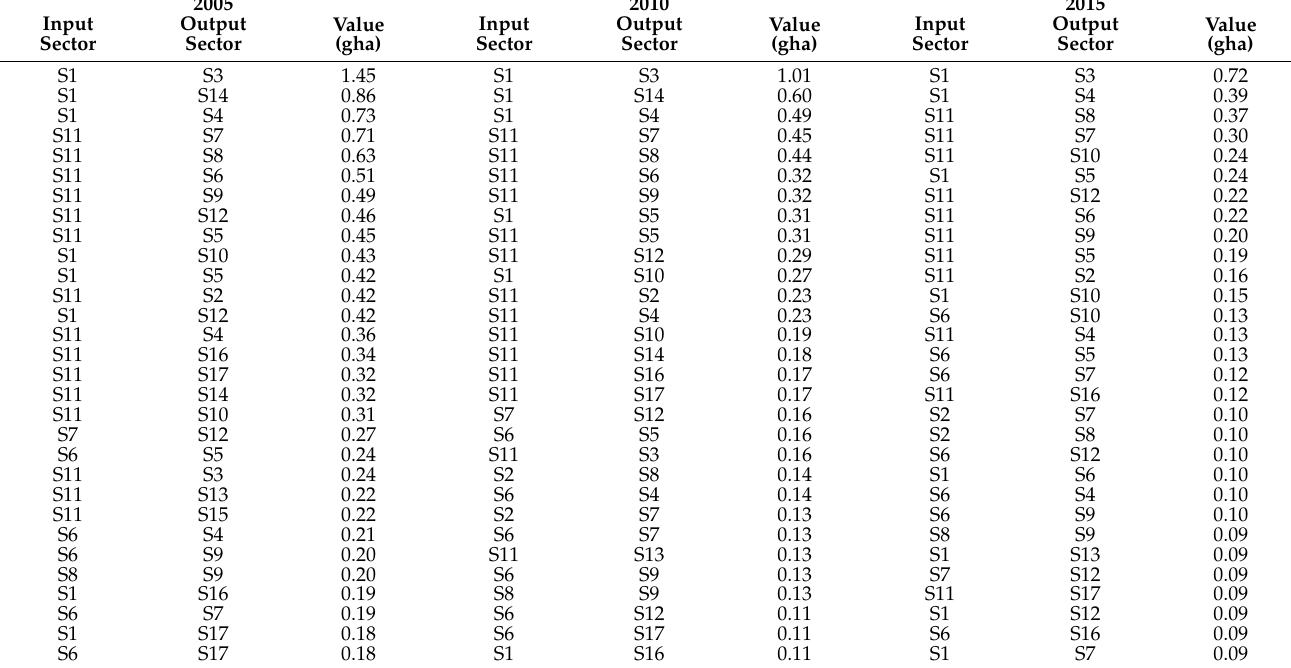
Table A2. The top 30 net EFPI component transfers between different sectors in 2005, 2010, and 2015.